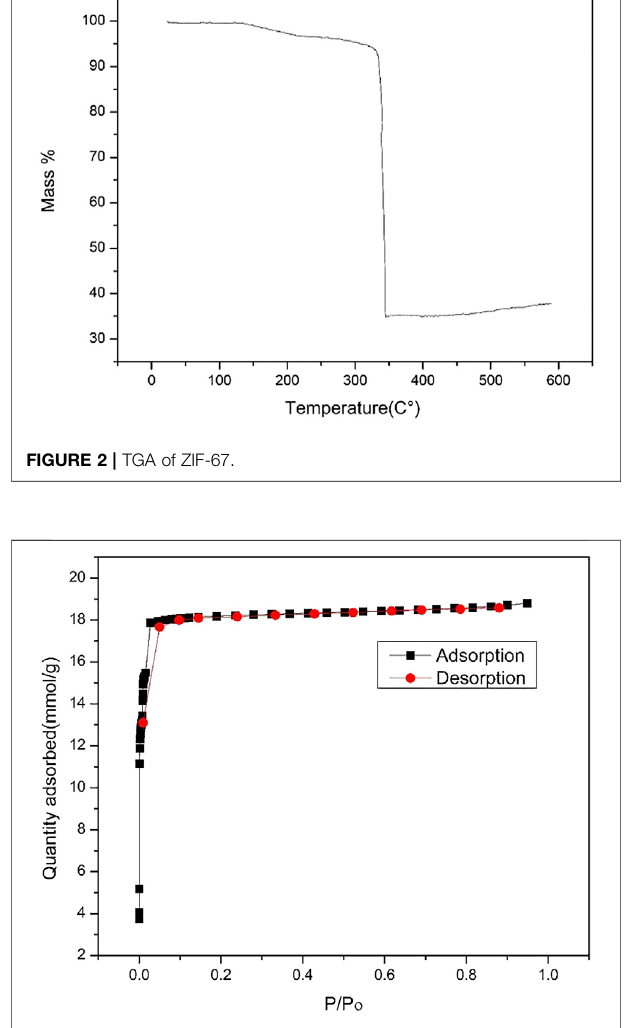
FIGURE 3 | N 2 77K adsorption – desorption isotherm of ZIF-67.